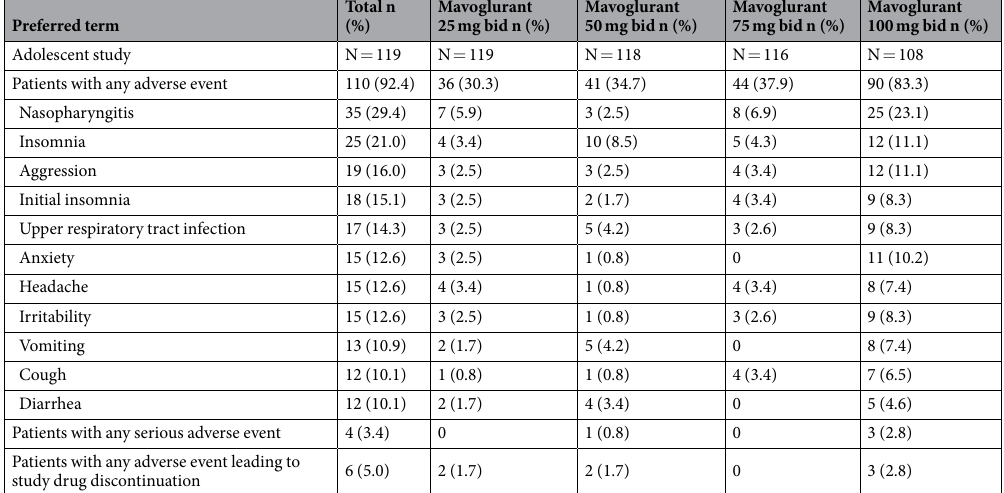
Table 2. Most frequent adverse events * in adolescent patients during the extension period, by last dose before event onset (safety population). * Incidence ≥ 10% in any group.